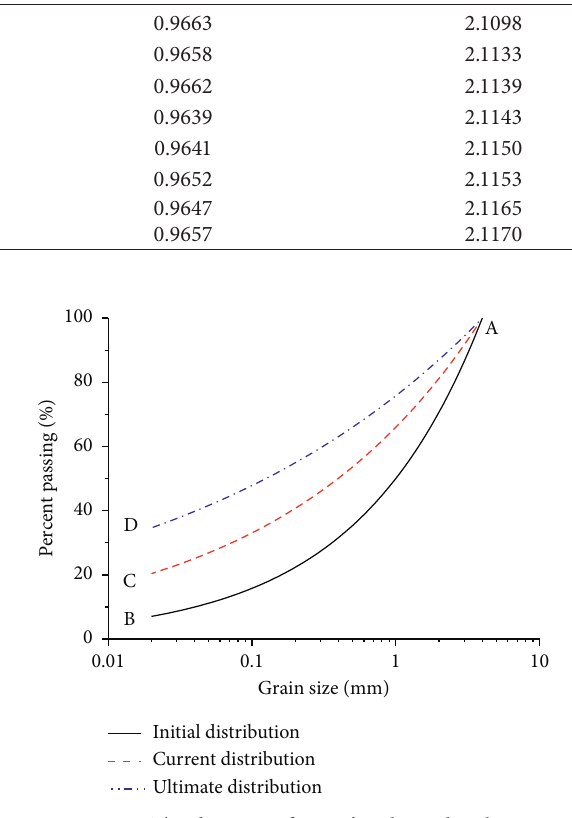
Figure 6: Comparison between the particle size distribution under different stress levels. Table 2: Fractal dimension D of calcareous sand samples at each stress level. Stress P (kPa)